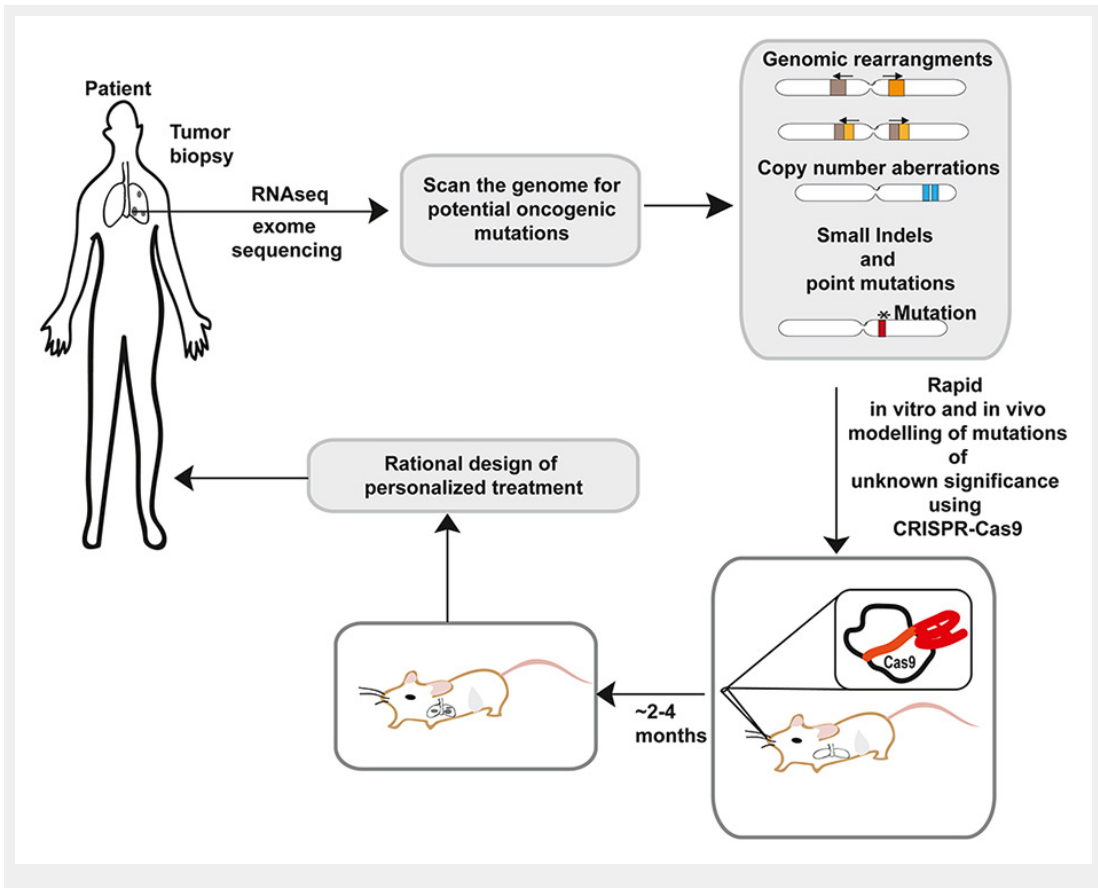
Figure 3 Applications of CRISPR-Cas9 in personalized medicine. A possible scenario for the use of CRISPR-Cas9 in personalized medicine. Genetic information derived from high-throughput analysis of the patient’s tumor samples often results in the identification of mutations of unclear pathogenetic significance in known oncogenes and tumor suppressors. CRISPR could be used to model such mutations in vitro and in vivo and rapidly determine their functional consequences. Such information can then be used to design an optimized personalized